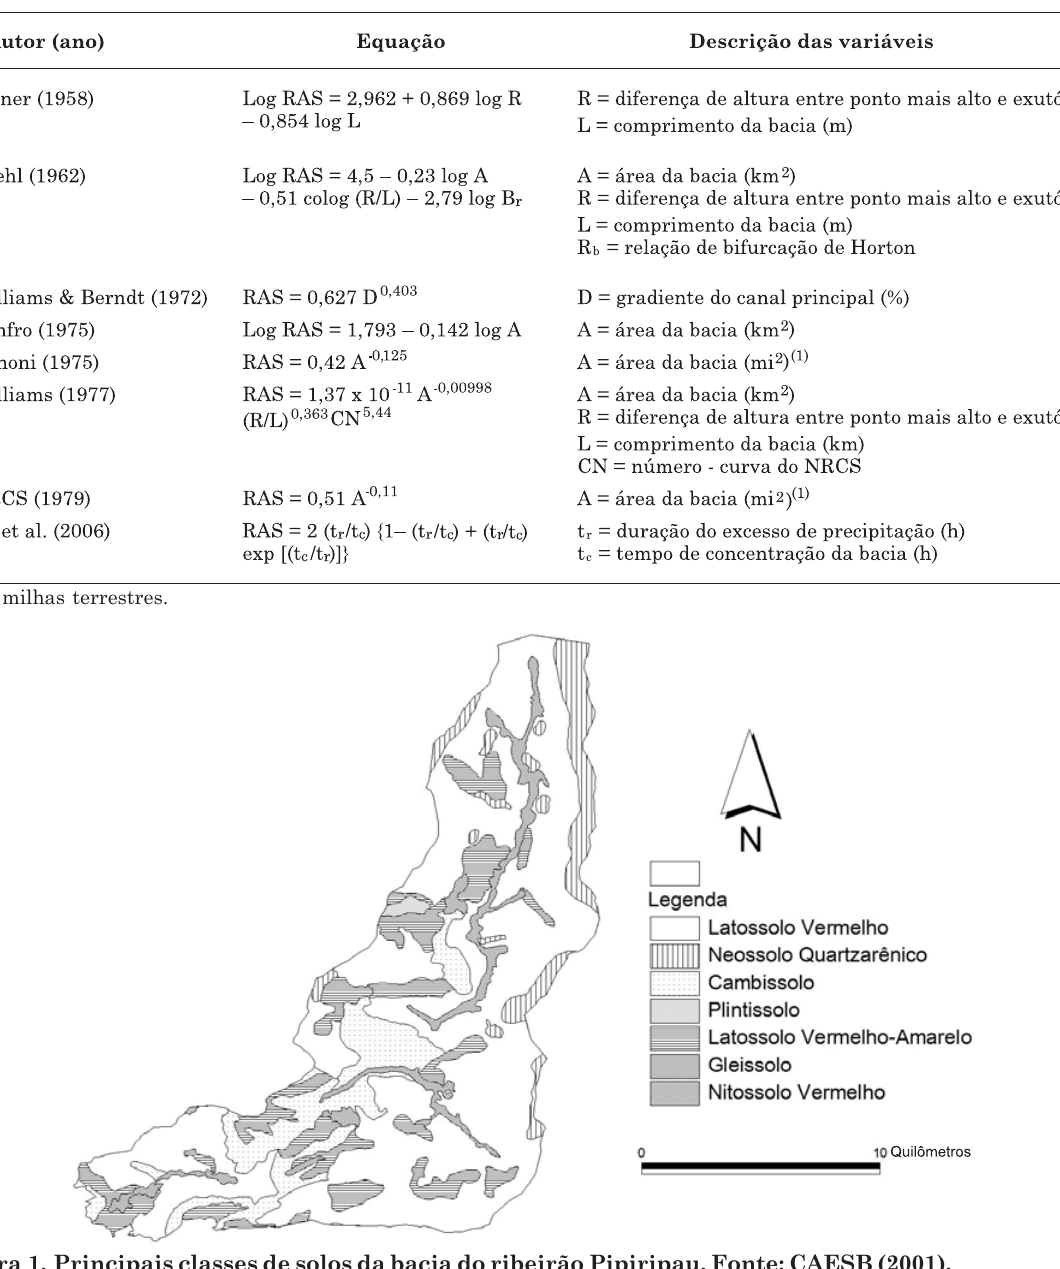
Figura 1. Principais classes de solos da bacia do ribeirão Pipiripau. Fonte: CAESB